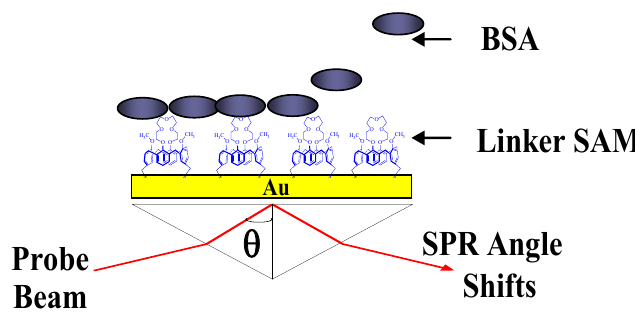
Figure 2. Schematic diagram of BSA immobilization on the calixarene monolayer.